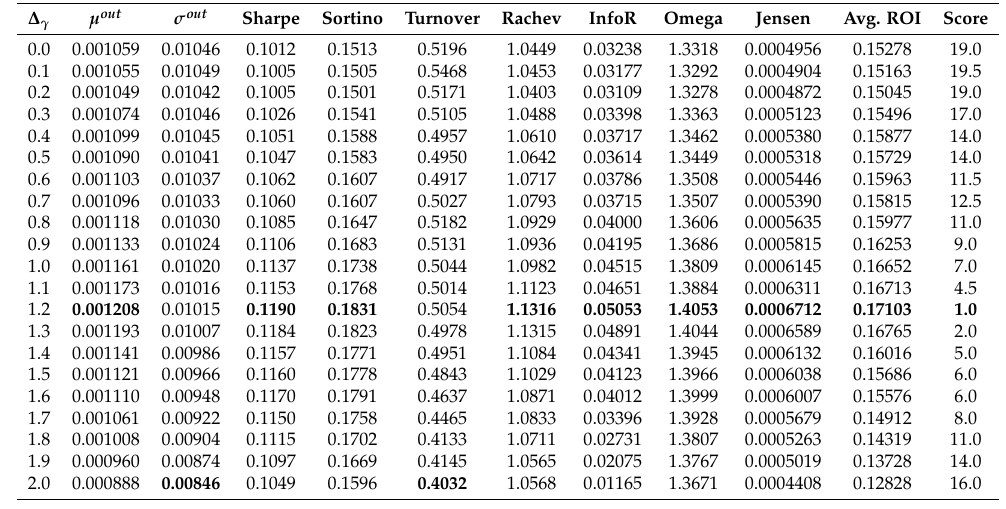
Table 16. CIB: out-of-sample performance results for the RMZ R strategy by varying ∆ γ , where ∆ γ is the skewness parameter and score is the median value of the overall performance rankings. The best results are marked in bold.